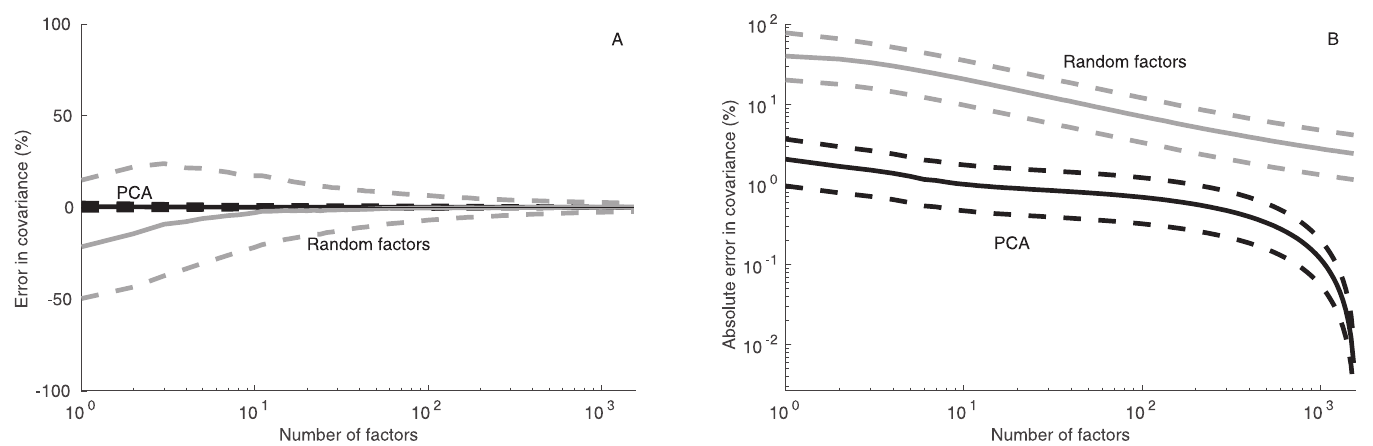
Fig 4. Accuracy of covariance estimation. Median error (left panel; solid gray curves; measure in percentage points) in covariance in all pairs in the data-set estimated using 1,000 different random factor models, together with 25th and 75th (dashed gray curves) percentiles of error in covariance estimates. The results are compared with the estimates of covariance based on PCA (solid black curve), together with the 25th and 75th (dashed black curves) percentiles. The results are shown as a function of the number of factors (abscissa). Median absolute error (right panel; solid gray curves; measure in percentage points) in covariance in all pairs in the data-set estimated using 1,000 different random factor models, together with the 25th and 75th (dashed gray curves) percentiles of error. The results are compared with the estimates of covariance based on PCA (solid black curve), together with the 25th and 75th (dashed black curves) percentiles.